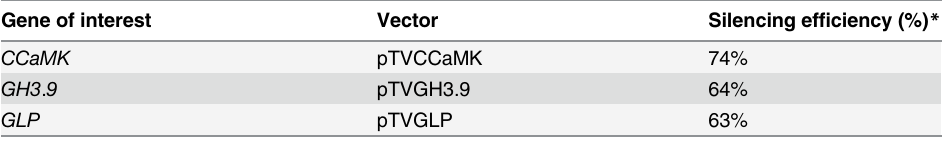
Table 2. Selected genes for the functional characterization by virus-induced gene silencing (VIGS). Silencing efficiency is shown as the percentage of cDNA of the genes of interest in VIGS-silenced plants